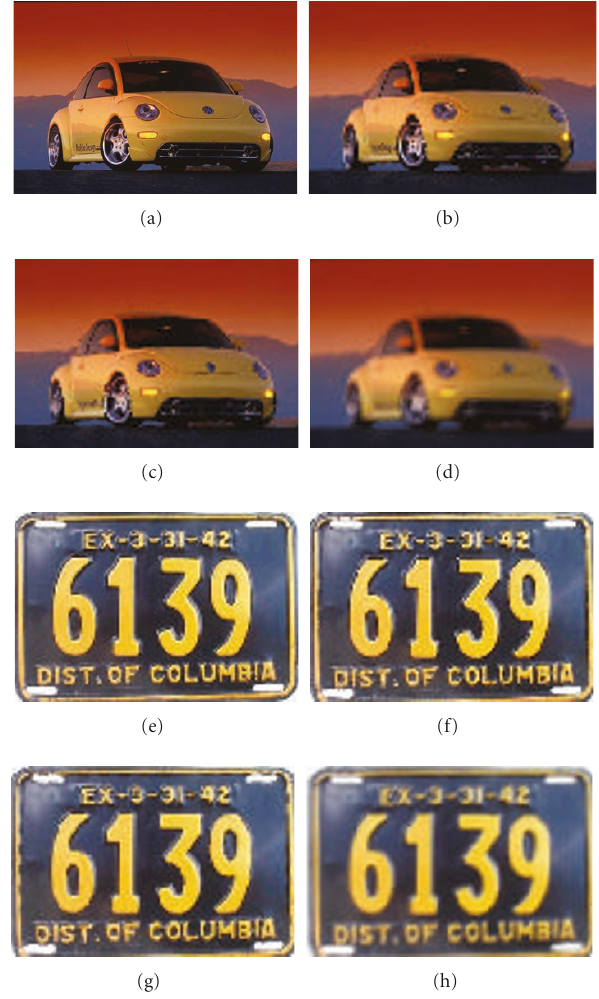
Figure 2: Image super-resolution. For each class, clockwise from top left: (a), (e) original image, (b), (f) quarter pixel accuracy, (d), (h) integer-pixel accuracy, (c), (g) half-pixel